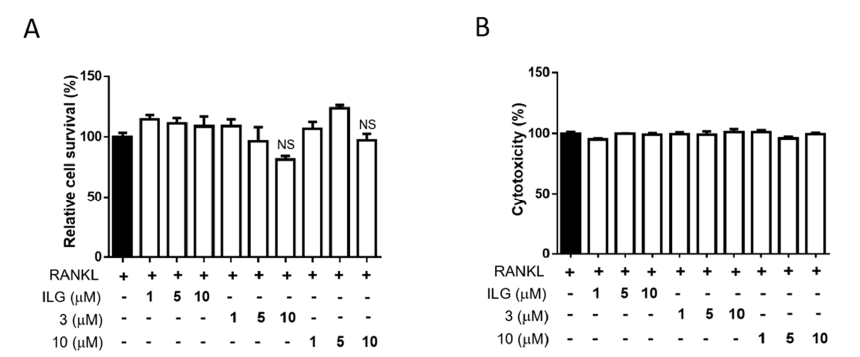
Figure 3. ILG and ILG derivatives inhibit osteoclast differentiation without cell death. The cell viability ( A ) and toxicity ( B ) on RAW264.7 cells were assessed in presence of RANKL (40 ng/mL) with various concentration (1, 5, and 10 μ M) of ILG or ILG derivatives. Data are presented as the mean ± SEM ( n ≥ 5).